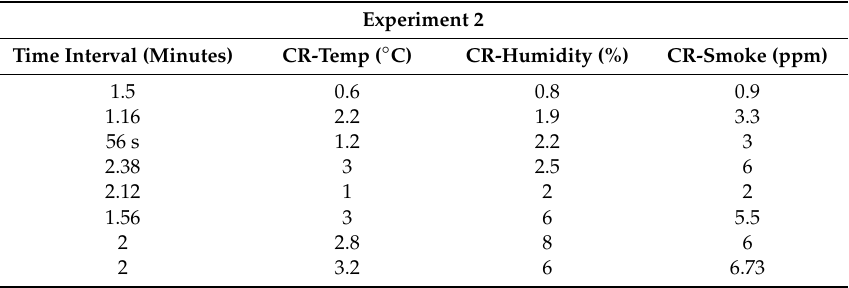
Table 3. C-R-Temp, C-R-Temp, and time of fire detection with experiment 2.